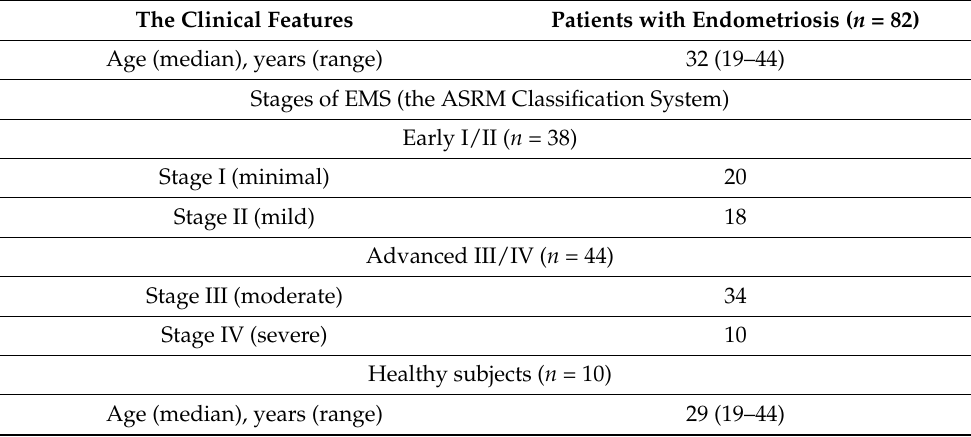
Table 3. Clinical characteristics of the EMS patients